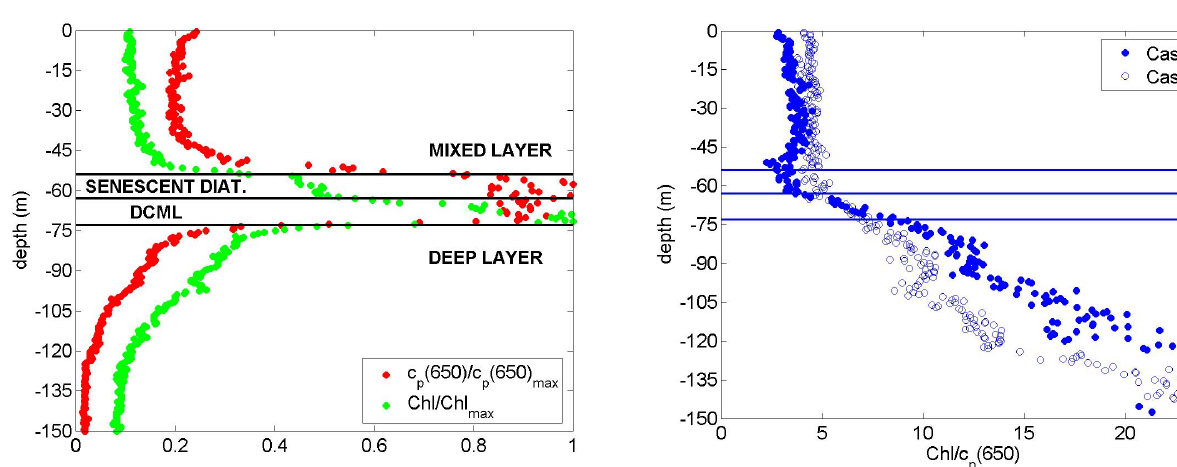
Fig. 8. Vertical profiles of [chl]/ c p for Casts 31 and